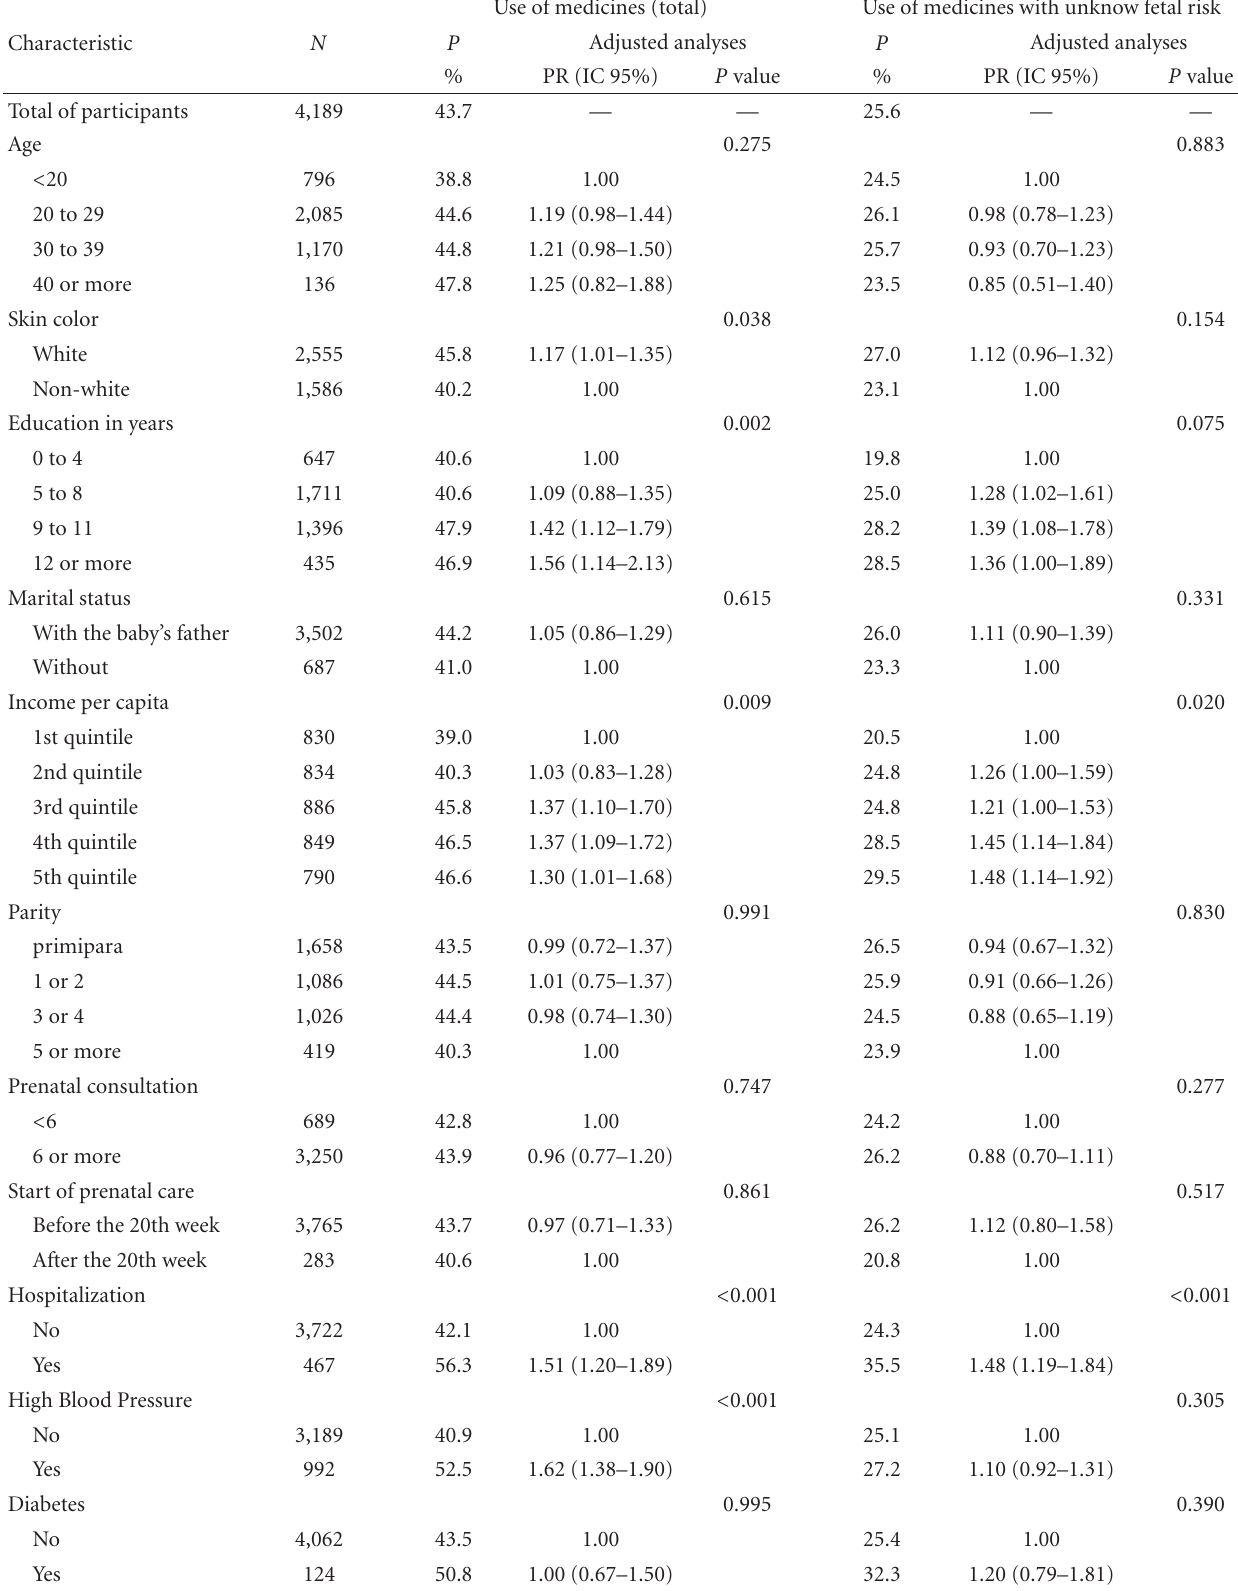
Table 4: Description of the sample and the health conditions of the mothers participating in the 2004 Birth Cohort ( N ), prevalence ( P %) and adjusted analyses of the use of medicines during pregnancy considering all medicines and the medicines with unknown fetal risk used, excluding vitamin and iron supplements. Birth Cohort of Pelotas, RS